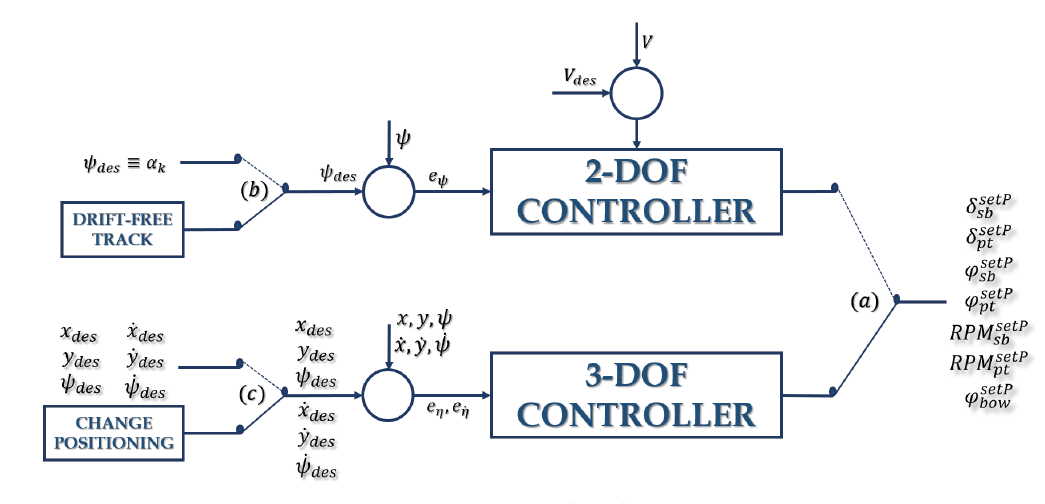
Figure 12. Switching logic.